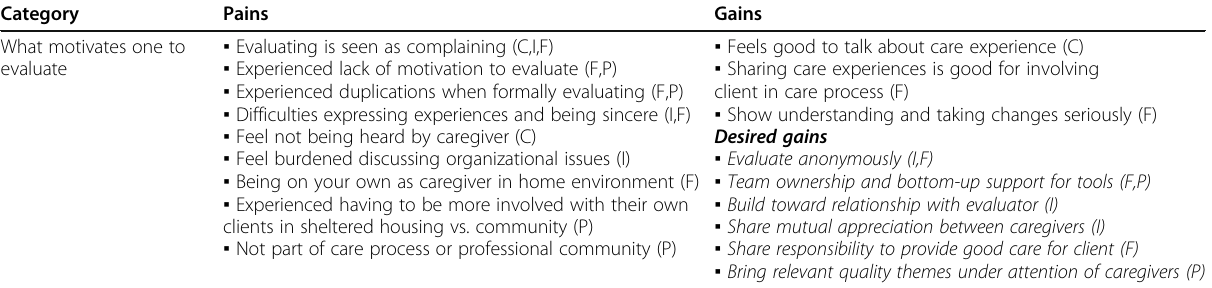
Table 6 Identified pains and (desired) gains ‘ what motivates to evaluate ’